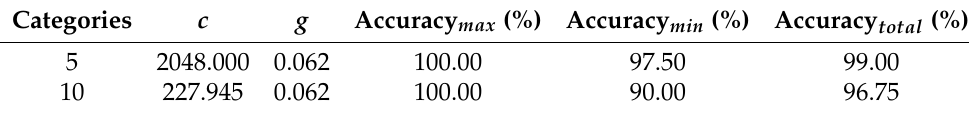
Table 8. Accuracy of different numbers of sample (MIT-BIH normal sinus rhythm